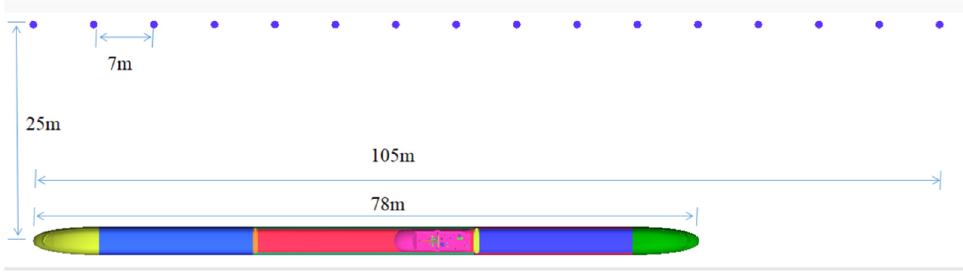
Figure 9. Sound receiver point layout diagram.